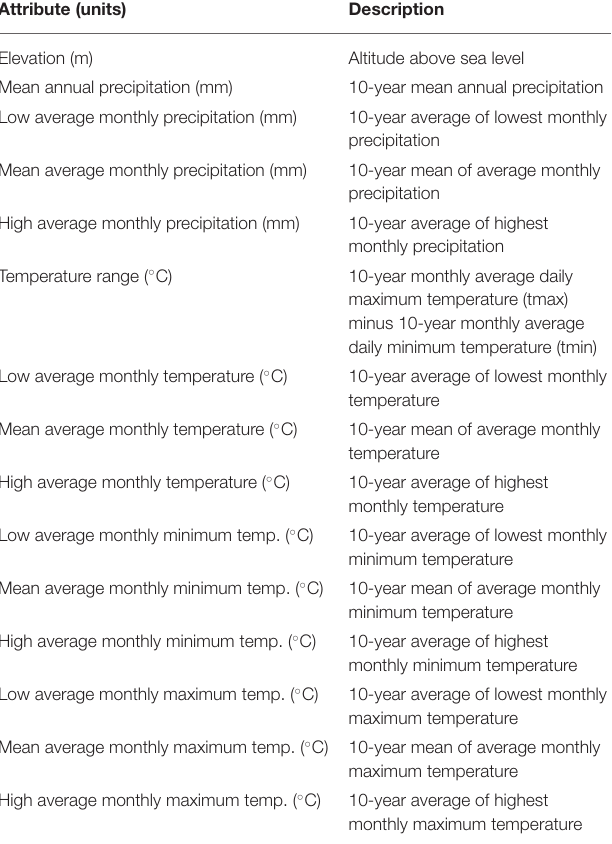
TABLE 1 | Environmental attributes analyzed for associations with Batrachochytrium dendrobatidis ( Bd ) occurrence (detection, no detection) across world sites with Bd sampling compiled through